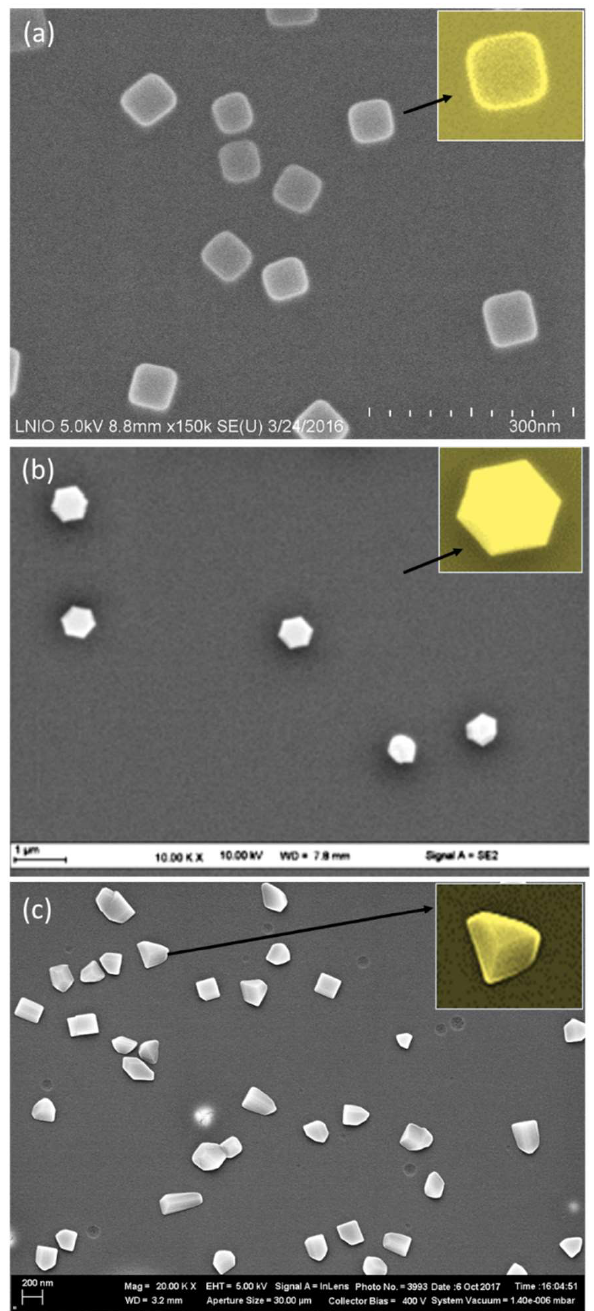
Figure 4. SEM images for three samples of gold nanoparticles prepared with a combination of acetone (PMMA solvent) and isopropanol/ethanol (precursor solvent), where ethanol was used in ( a ) and isopropanol in ( b ) and ( c ). The samples basically differ in the gold precursor molecules: ( a ) 60 mM of NaAuCl 4 , ( b ) 100 mM HAuCl 4 , and ( c ) 100 mM KAuCl 4 . The inserts in ( a ), ( b ), and ( c ) show the formation of monodispersed nanocubes, nanohexagons, and nanoprisms, respectively. Scale bars are 200 nm for a and ( c ) and 1 µm for ( b ).